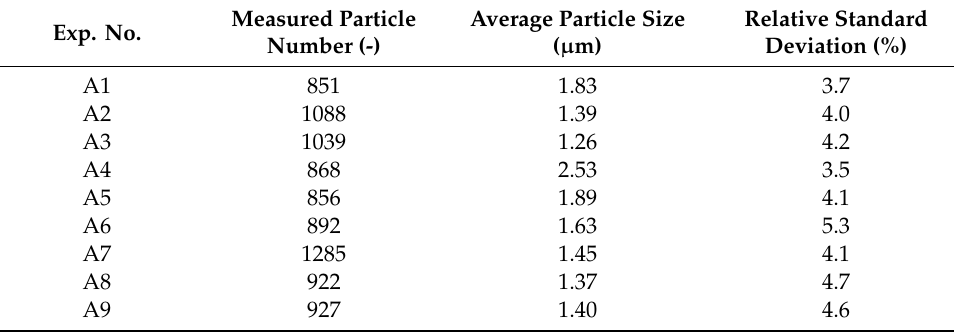
Table 3. Experimental results of Taguchi’s orthogonal